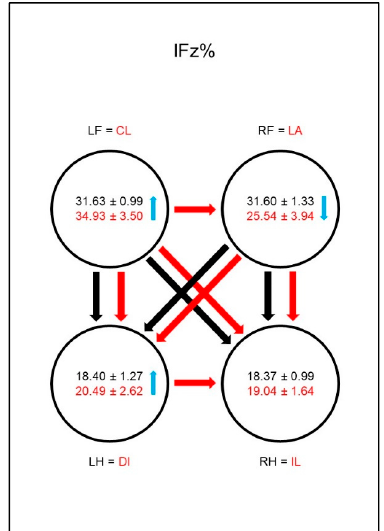
Figure 12. Vertical impulse as a percentage of total force (IFz%) in study group 2 and control group. For detailed explanation and abbreviations refer to Figure 2.